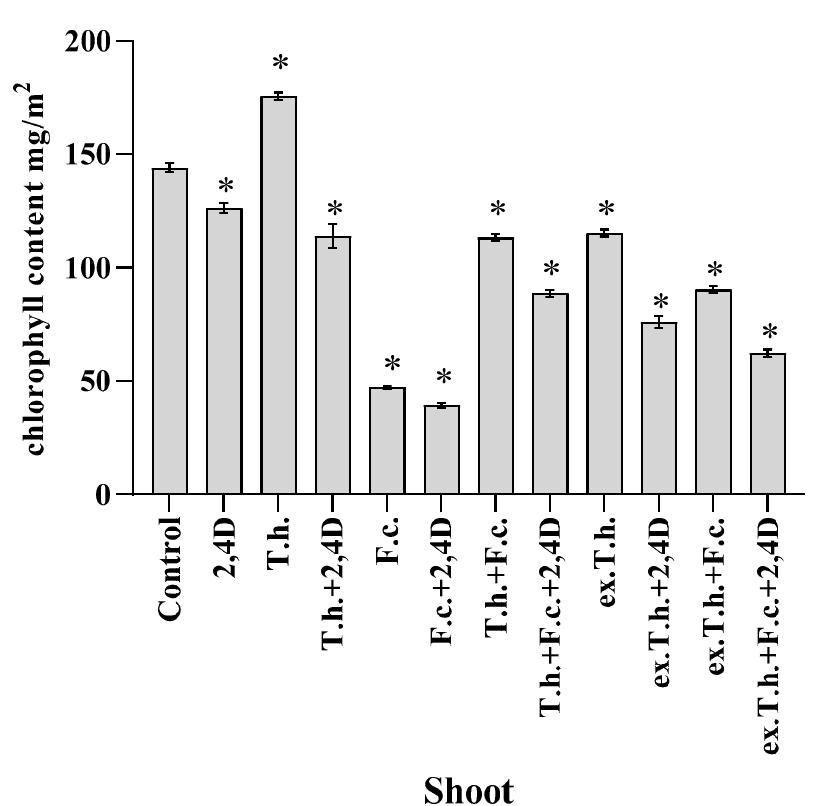
Figure 3. Chlorophyll contents in shoots measured after 7 days of cultivation (T.h.— T. harzianum - inoculated wheat seeds; F.c.— F. culmorum -inoculated wheat seeds; ex.T.h.— T. harzianum extracellular metabolite-treated wheat seeds). Data represent means ± SE; the significance of the variance study with Tukey’s post hoc test = * p ≤ 0.01. The subcolumn statistic comparison is attached in supplementary material as Table S3.